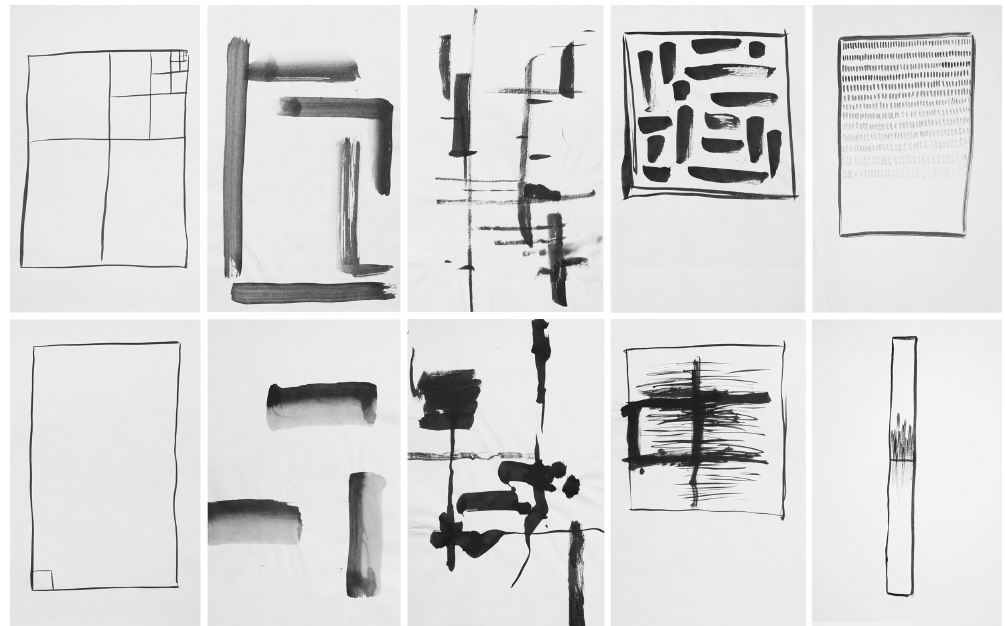
Fig. 5 Class project, compositions by five participants, Institute of Visual Communication, Basel School of Design HGK